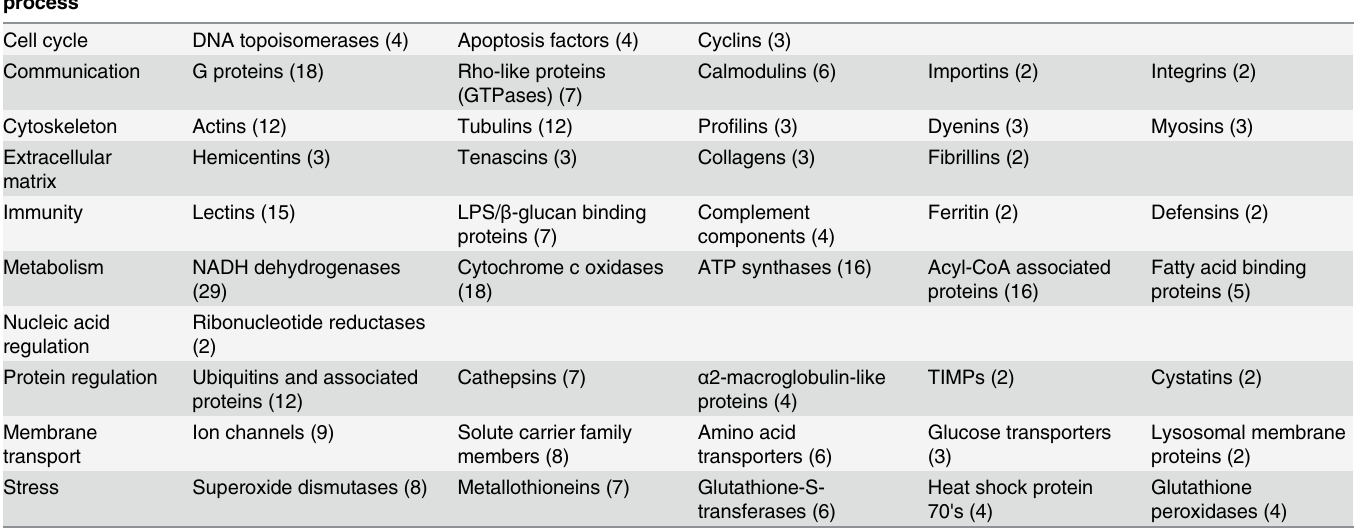
Table 4. The top fi ve most commonly identi fi ed types of differentially expressed genes in the main intracellular process categories affected by environmental stress. Intracellular process